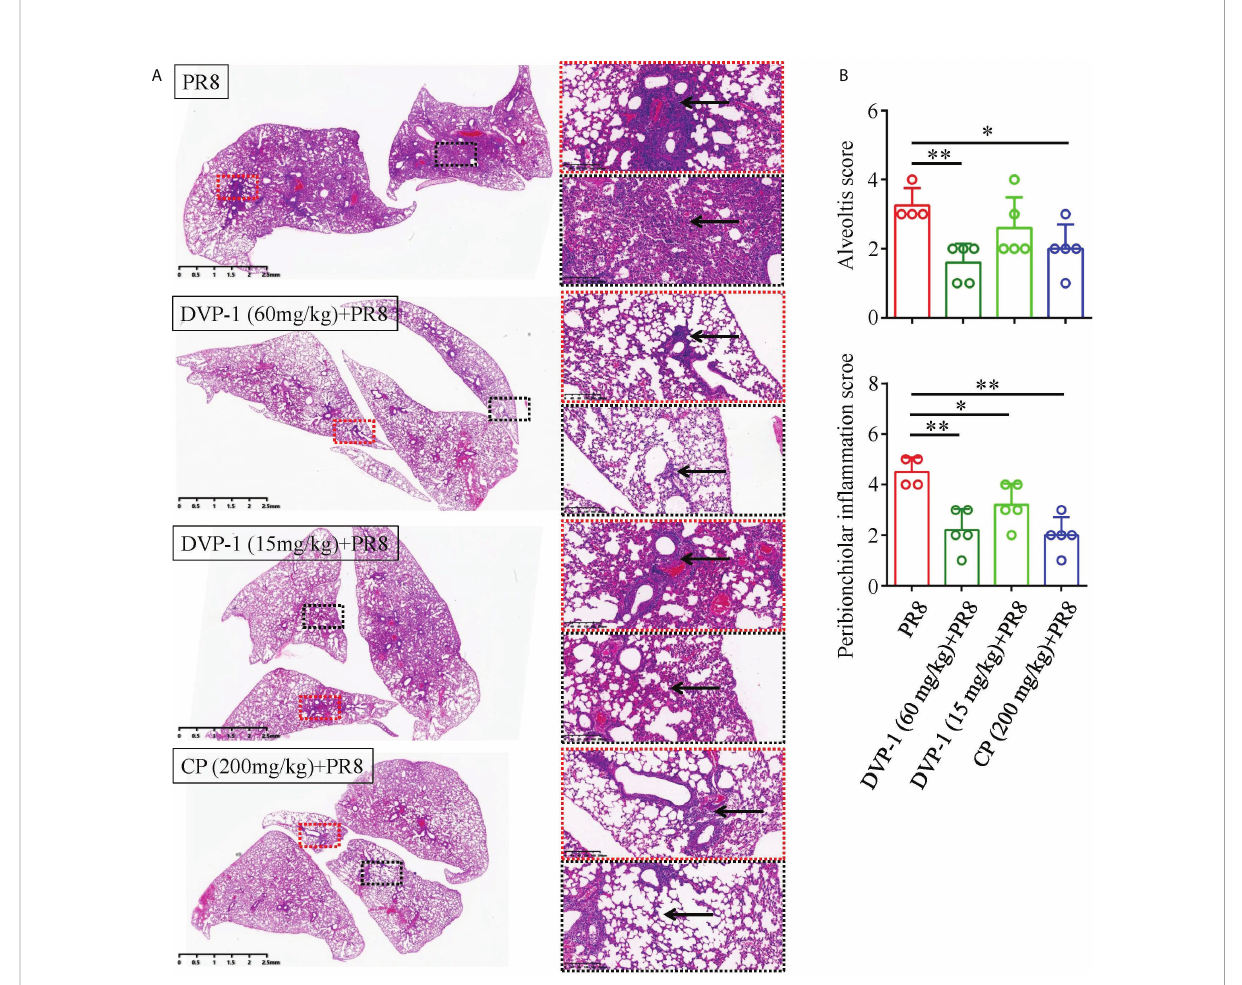
FIGURE 6 Histopathological results of the lungs. (A) Lung tissue was stained by HE to detect histopathological changes (1×, 10×), where the red box represents in fl ammation around the bronchus, and the black box represents alveolar in fl ammation. (B) Quantitative analysis of alveolar in fl ammation and peribronchiolar in fl ammation (in fl ammation was divided into 1-5 grades from low to high). *p < 0.05, **p <